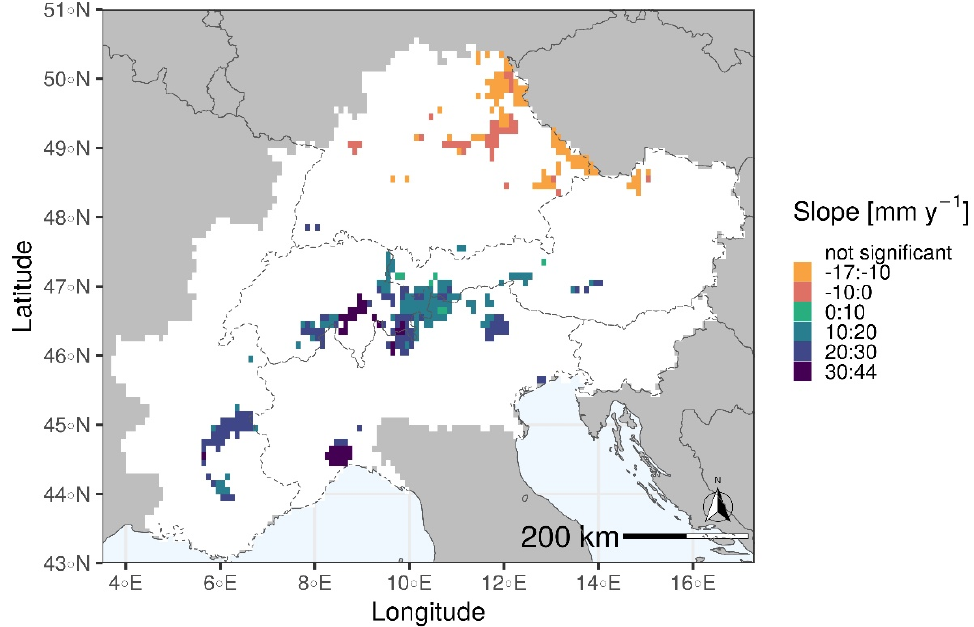
Figure 8. Sen’s slope of the trend, from 2003 to 2019, at 5% significance level, for yearly total precipitation, tp , from the MSWEP dataset.